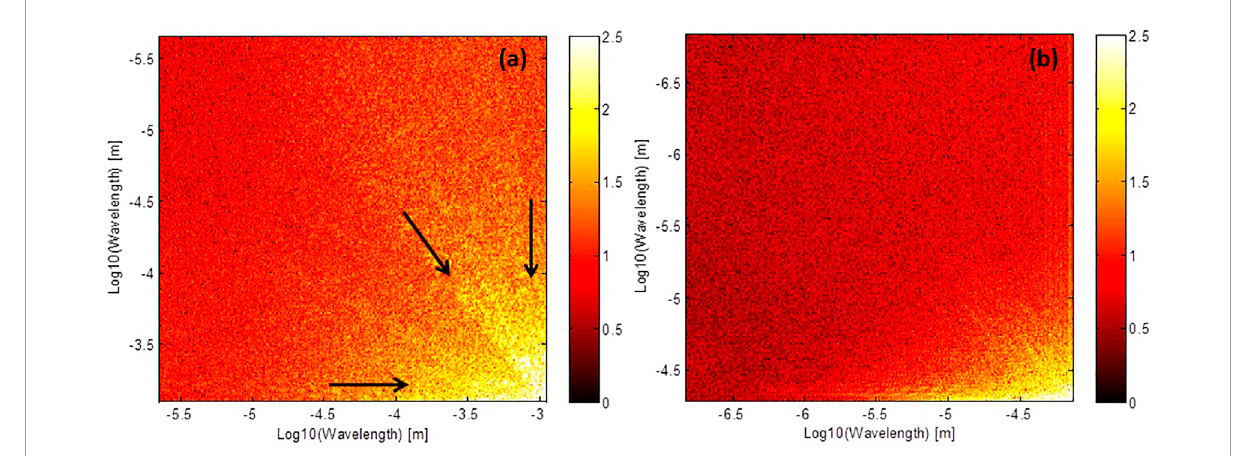
FIGURE 7 FFT bidimensional spectra, Log 10 λ y vs. Log 10 λ x (with λ in [m]), measured for the untreated fabric from images at different magnifications: (A) ×100 and (B) ×1,500. The arrows indicate directions of higher intensity.